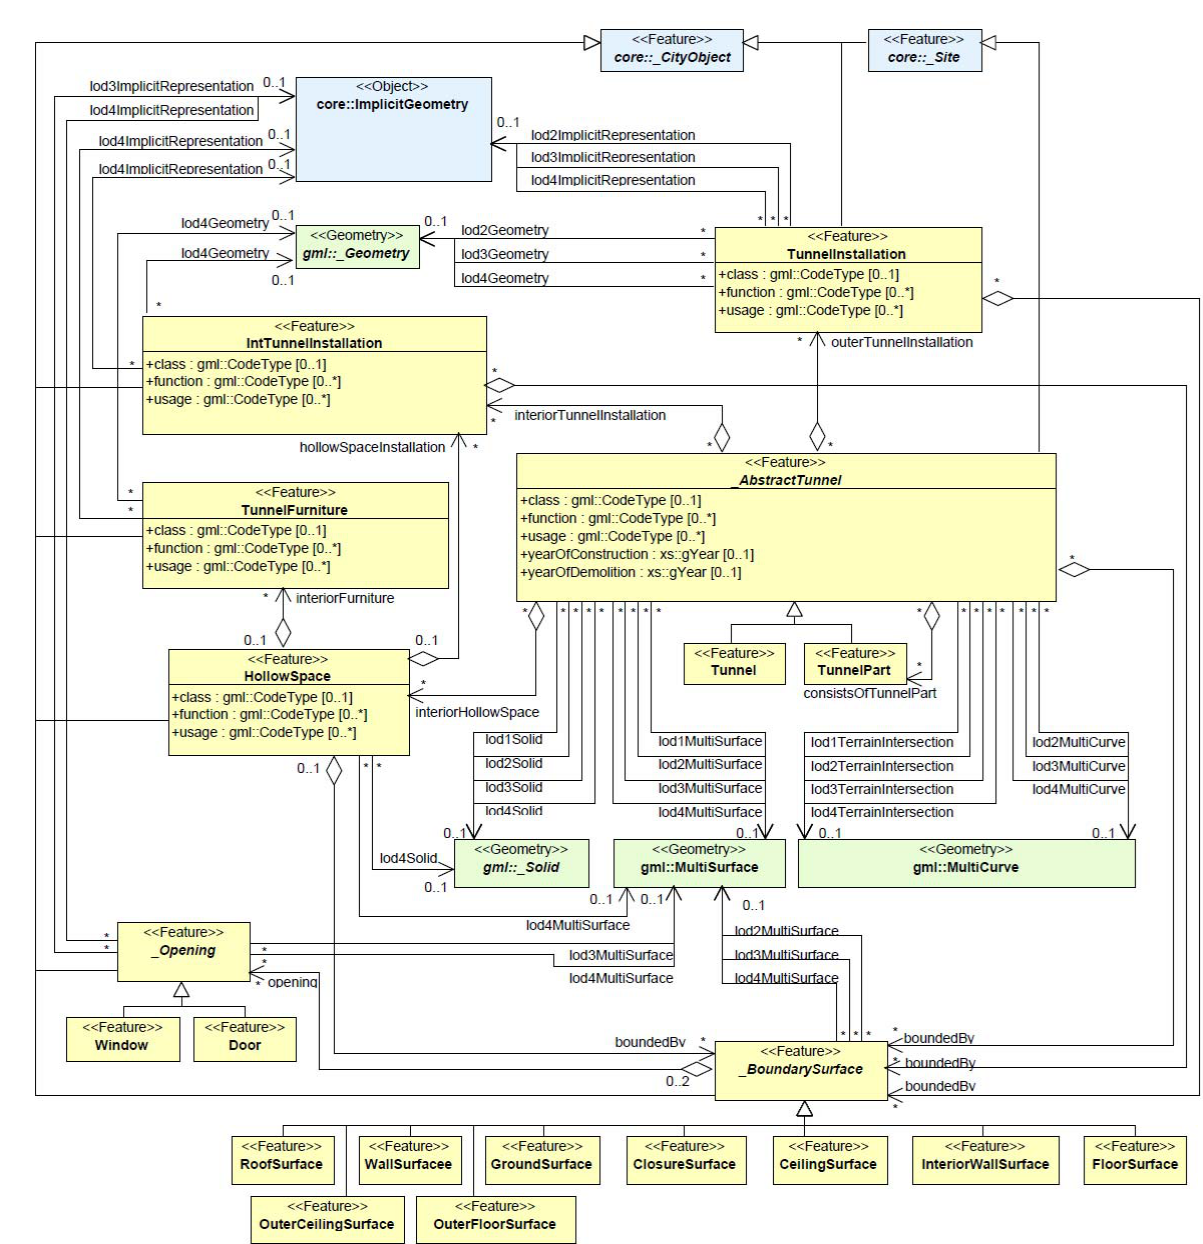
Figure 1. The CityGML data model for the multi-scale representation of tunnels (Source: (Gröger et al.